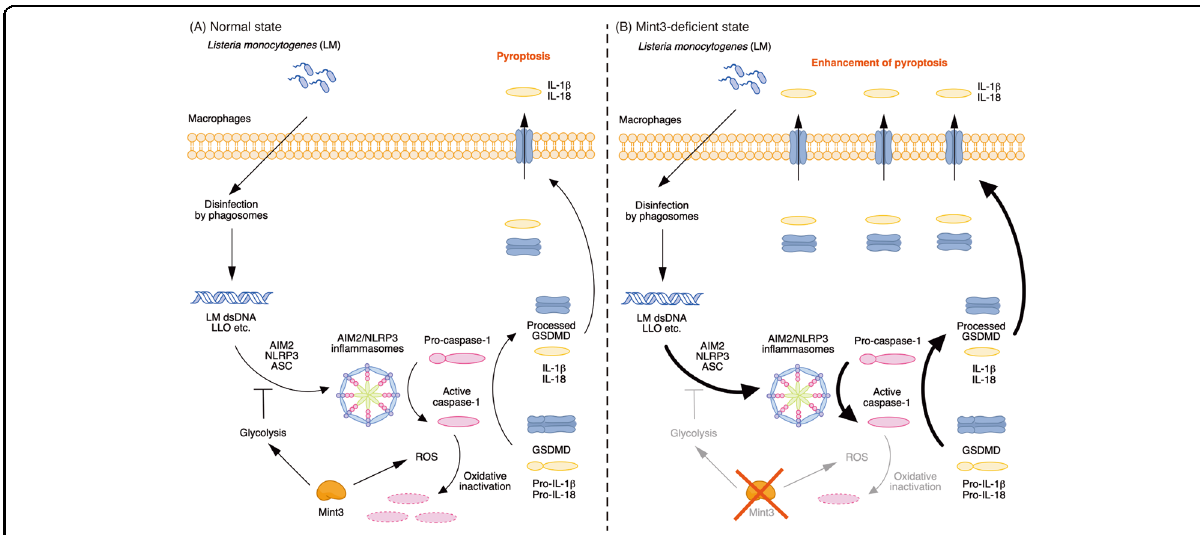
Fig. 8 Mint3 controls in fl ammasome activation and pyroptosis in LM-infected macrophages. ( A ) Mint3-mediated glycolysis inhibits ASC aggregation and the resulting in fl ammasome activation during LM infection. In addition, Mint3-mediated production of reactive oxygen species also inactivates caspase-1. Thus, Mint3 suppresses caspase-1-dependent GSDMD processing and pyroptosis in macrophages during LM infection. ( B ) When Mint3 is depleted, in fl ammasome activation and pyroptosis are enhanced in macrophages during LM infection, thereby serving to attenuate LM proliferation in macrophages and the associated